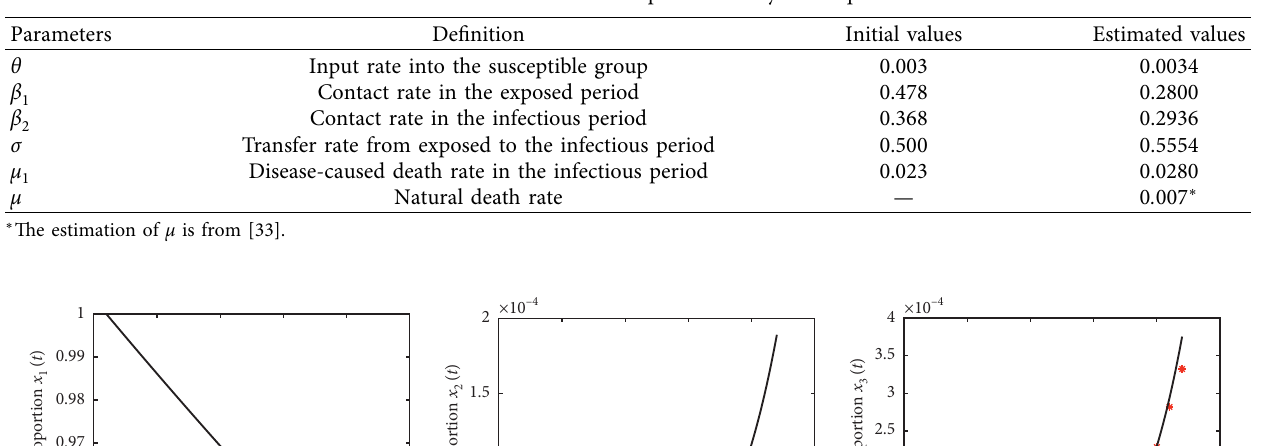
( t ) in Hubei province, from 15 January 3